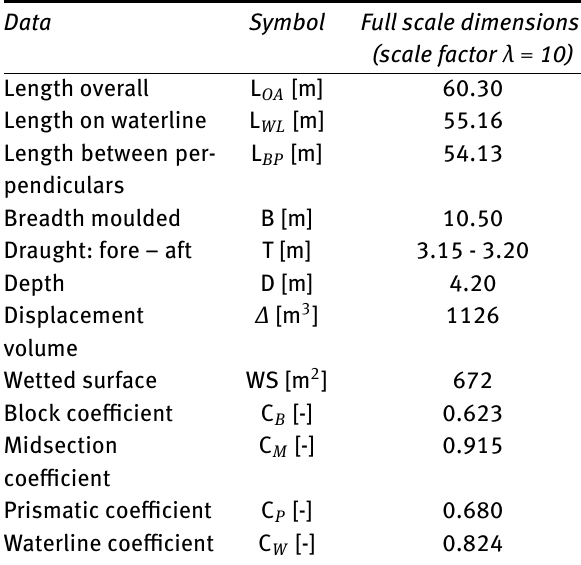
Table 1: Main dimensions in full scale of the RV Nawigator XXI.